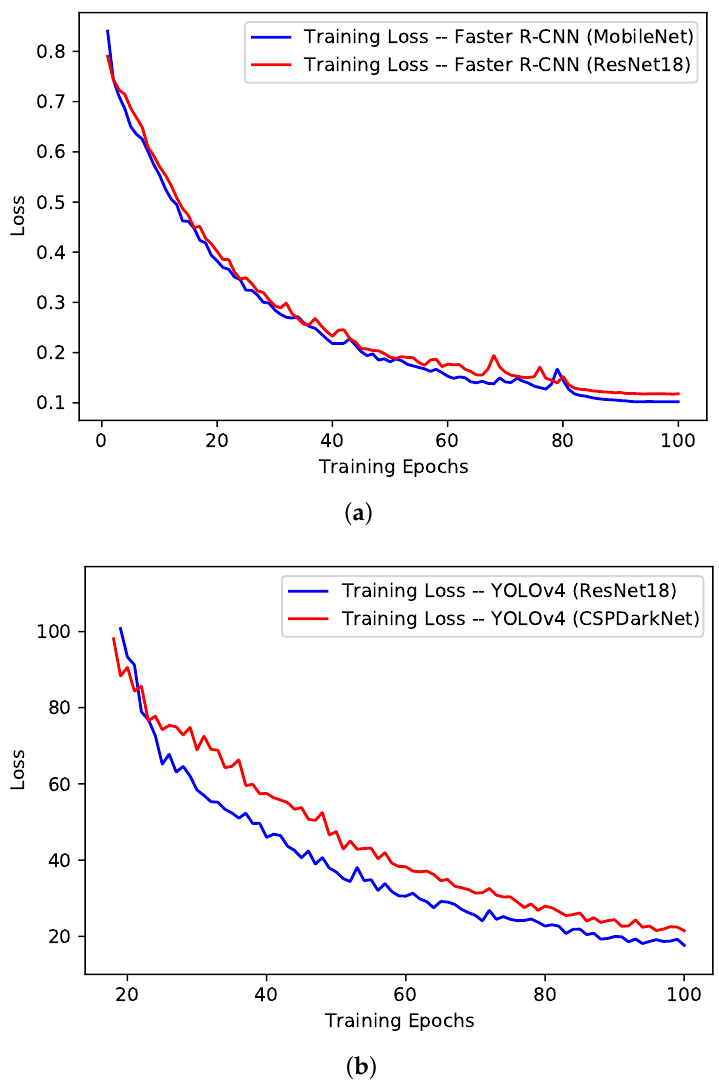
Figure 4. Training Loss Curves for the Different Variants of Computer Vision Object Detection Models Implemented for Floodborne Object Type Recognition: ( a ) Faster R-CNN Models, ( b ) YOLOv4